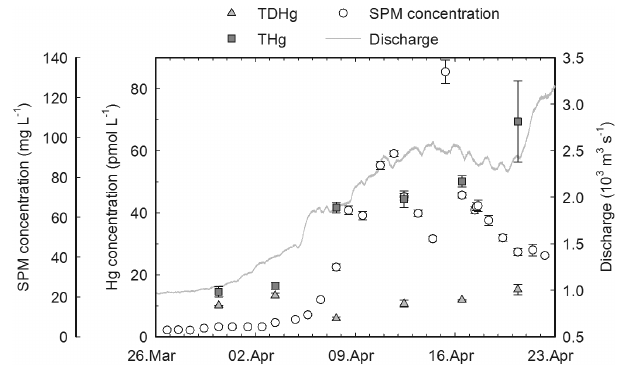
Figure 7. Total mercury concentrations in filtered (TDHg) and un- filtered (THg) water samples during the 2013 early freshet period. Error bars represent 1 s.d. of repeated